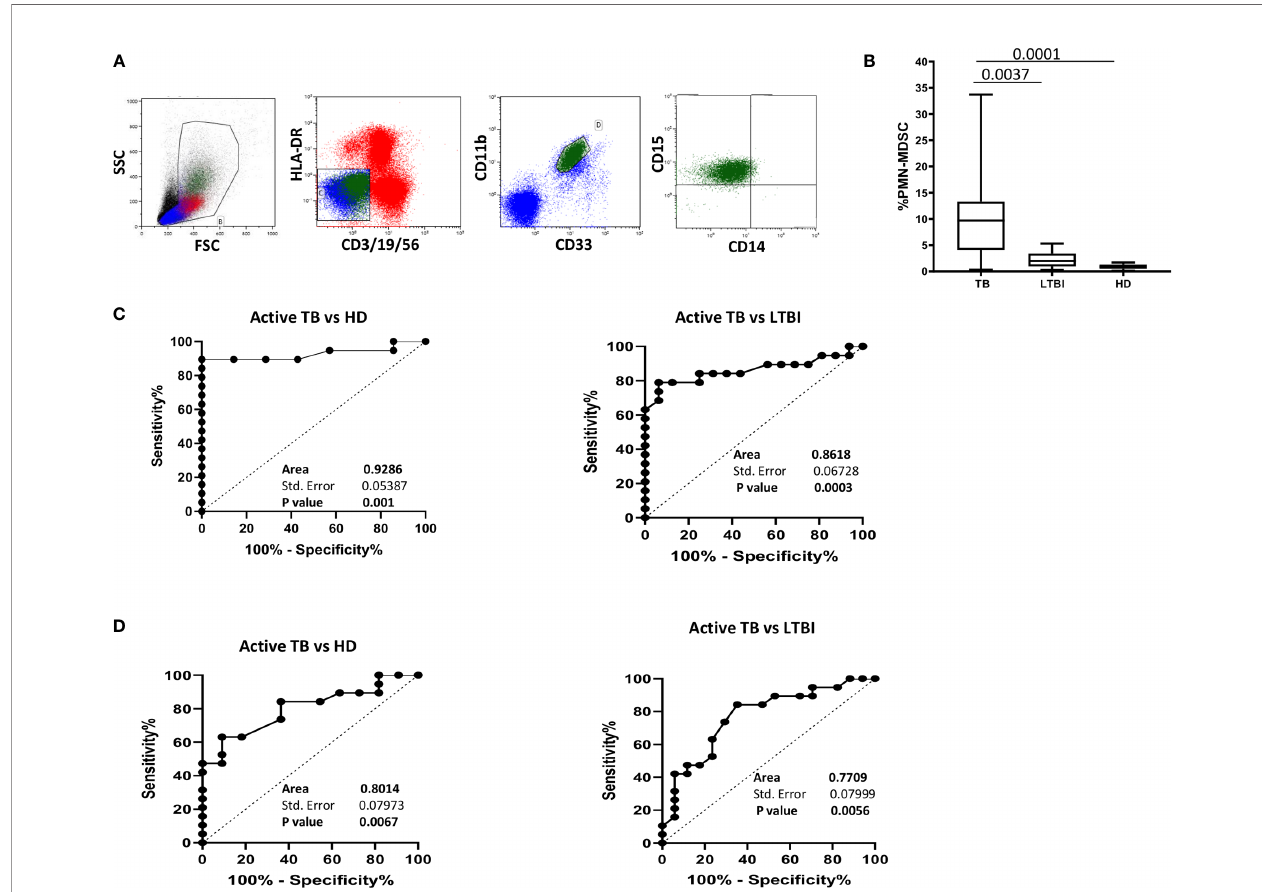
FIGURE 1 | PMN-MDSC discriminate active TB and LTBI. (A) Gating strategy used to identify MDSC: in the morphological gate (FSC/SSC) we excluded debris, then we gated Lin-/HLA DRlow/- cells. In this gate, we selected CD11b+CD33+ cells (MDSC). Then, the expression of CD14, CD15 is shown. The percentage of Lin-/HLA-DR-/CD11b+/CD33+ has been calculated in the morphological gate. (B) PMN-MDSC frequency in active TB (18), LTBI (19) and HD (12). Results are shown as Box and Whiskers. The Kruskall-Wallis test (with Dunn ’ s multiple comparison posttest) was applied. (C) Receiver operating characteristic (ROC) curve for the PMN-MDSC frequency. Right panel TB vs HD, left panel TB vs LTBI. (D) Receiver operating characteristic (ROC) curve for the Mo/Ly ratio. Right panel TB vs HD, left panel TB vs LTBI. PMN-MDSC: polymorphonuclear-myeloid-derived suppressor cells; TB, tuberculosis; LTBI, latent tuberculosis infection; HD, healthy